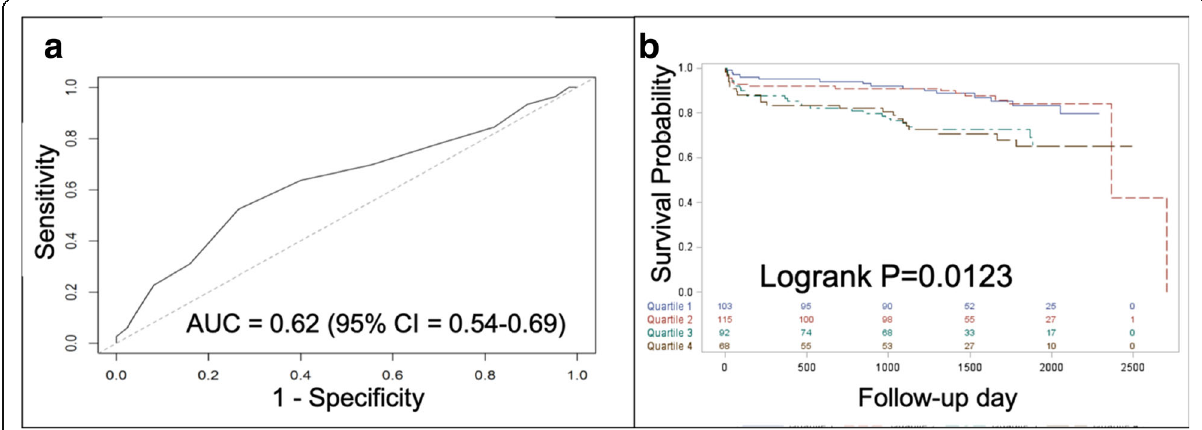
Fig. 2 External validation of point score system in the prompt CABG arm. a Receiver operator characteristic (ROC) curve. b Comparison of survival curves based on quartiles of risk score (blue = first quartile; red = second quartile; green = third quartile; brown = fourth